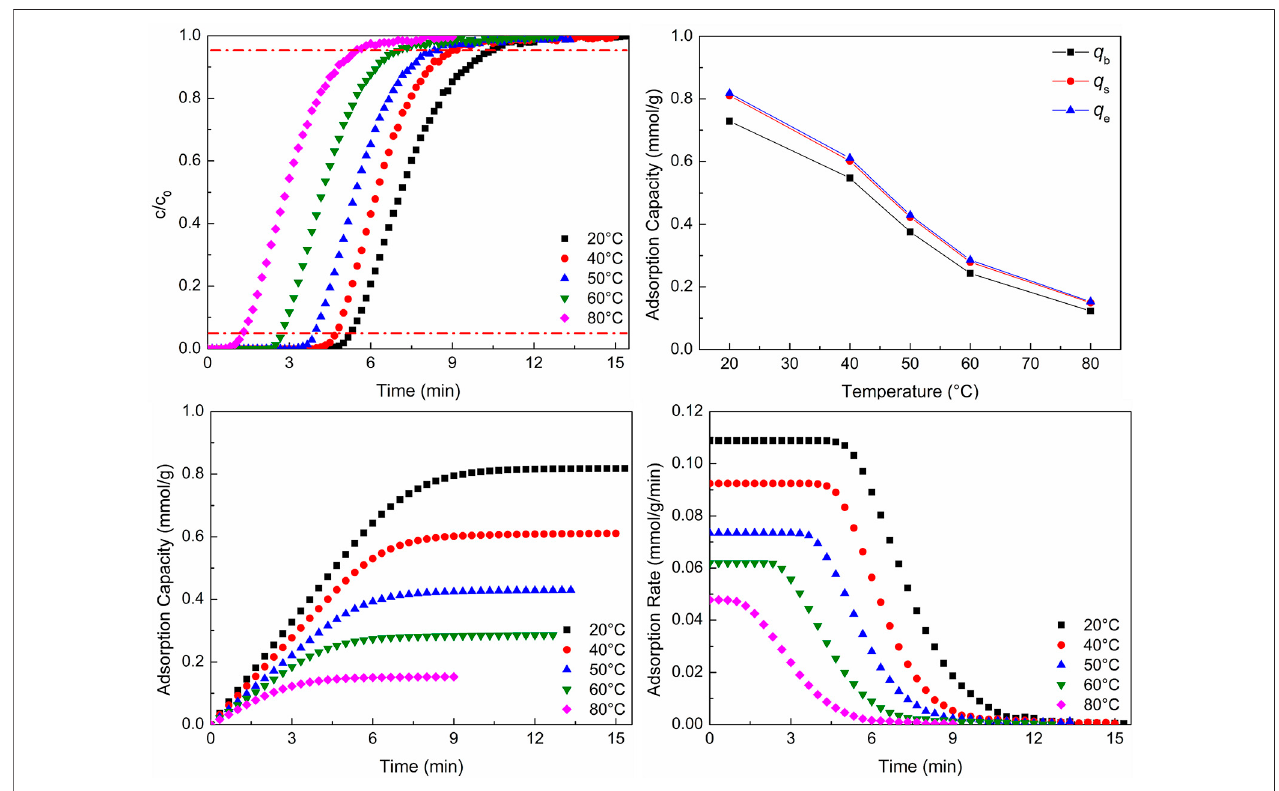
FIGURE 4 | CO 2 adsorption properties at different adsorption temperatures: (A) breakthrough curves; (B) adsorption capacity; (C) adsorption process; (D) adsorption rate.